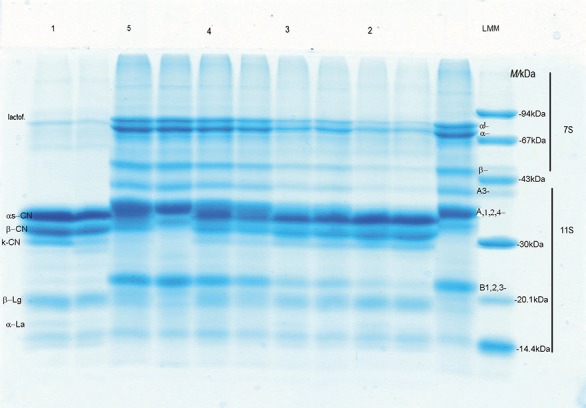
SDS electropherograms of soluble dairy protein beverages at the end of fermentation. Lane 1=100% cow's milk, lane 2=75% cow's milk+25% soy beverage, lane 3=50% cow's milk+50% soy beverage, lane 4=25% cow's milk+75% soy beverage, and lane 5=100% soy beverage, α`-, α- and β-subunits of β-conglycinin (7S). A=acid and B=base glycinin (11S), LMM=low-molecular-mass protein marker, laktof.=lactoferrin, La=lactalbumin, Lg=lactoglobulin, CN=casein